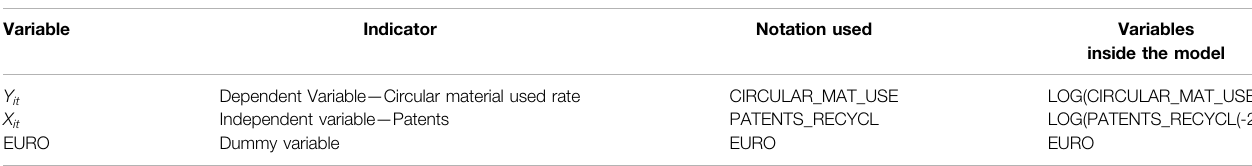
TABLE 3 | Variables considered and notations used.